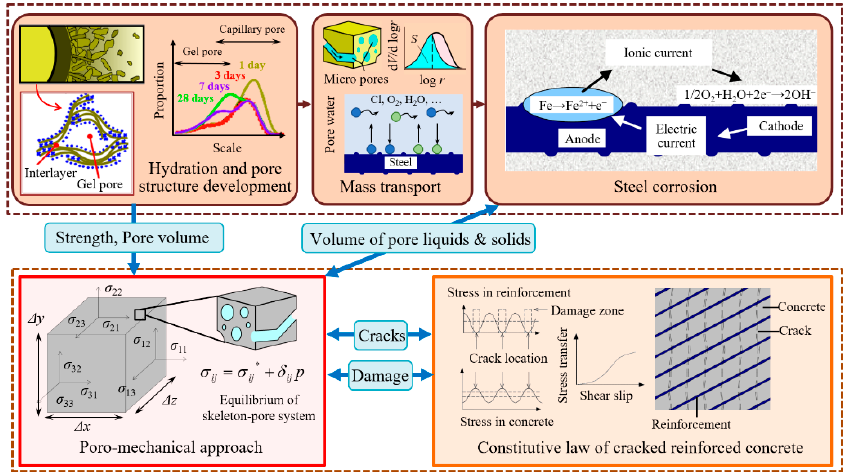
Figure 1. Framework for predicting the whole process of corrosion-induced cracking.